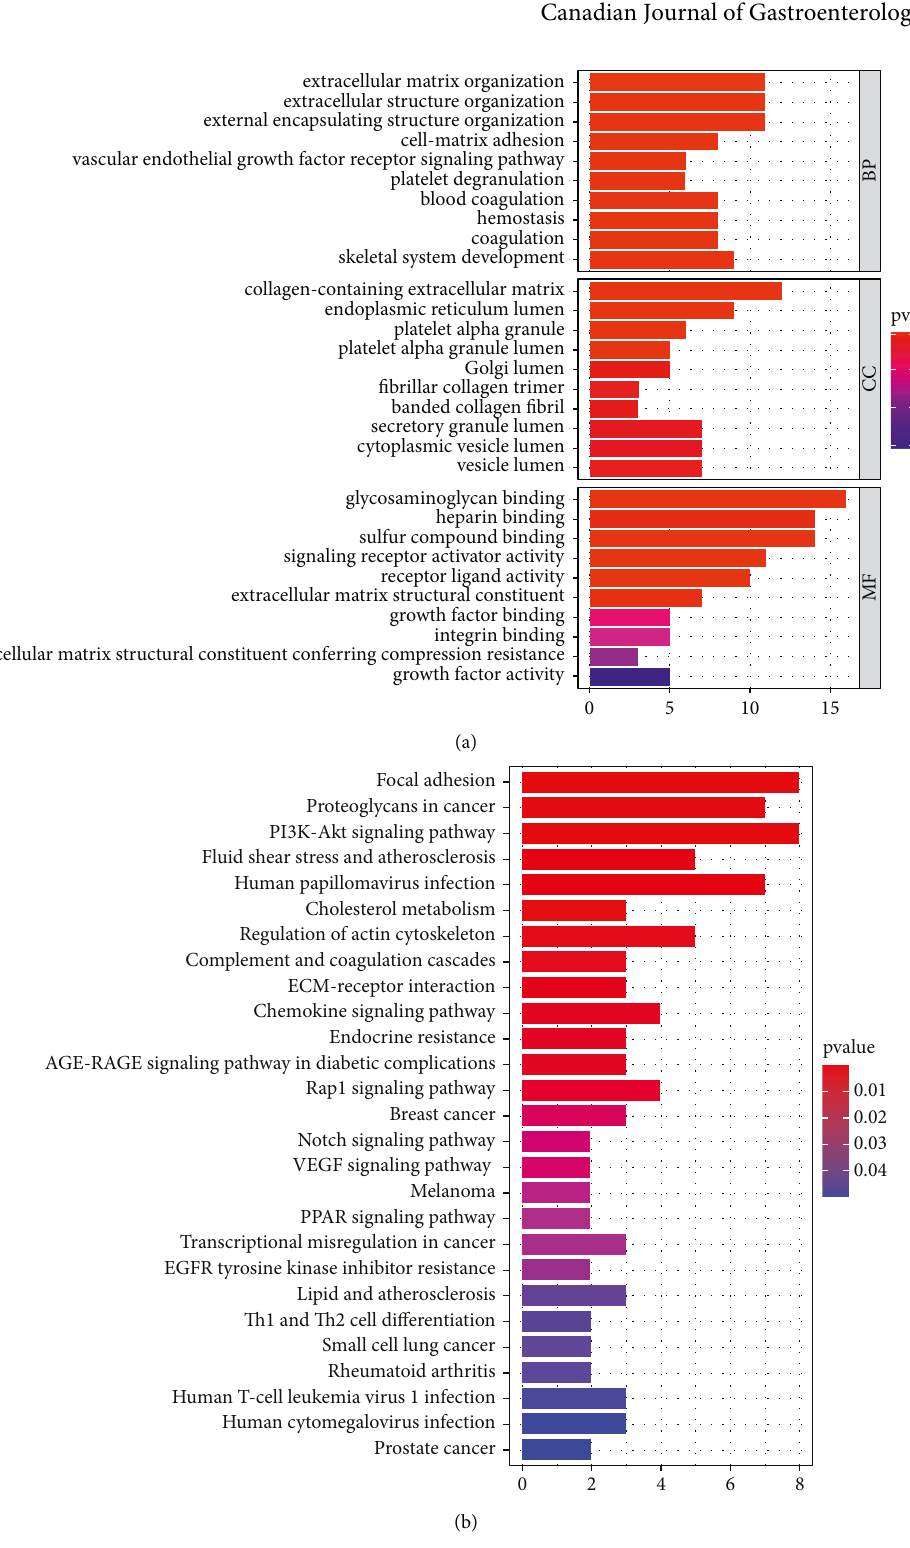
Figure 6: Functional analysis of genes from tumor gene set identified by LASSO method. (a) GO enrichment analysis. (b) KEGG en- richment